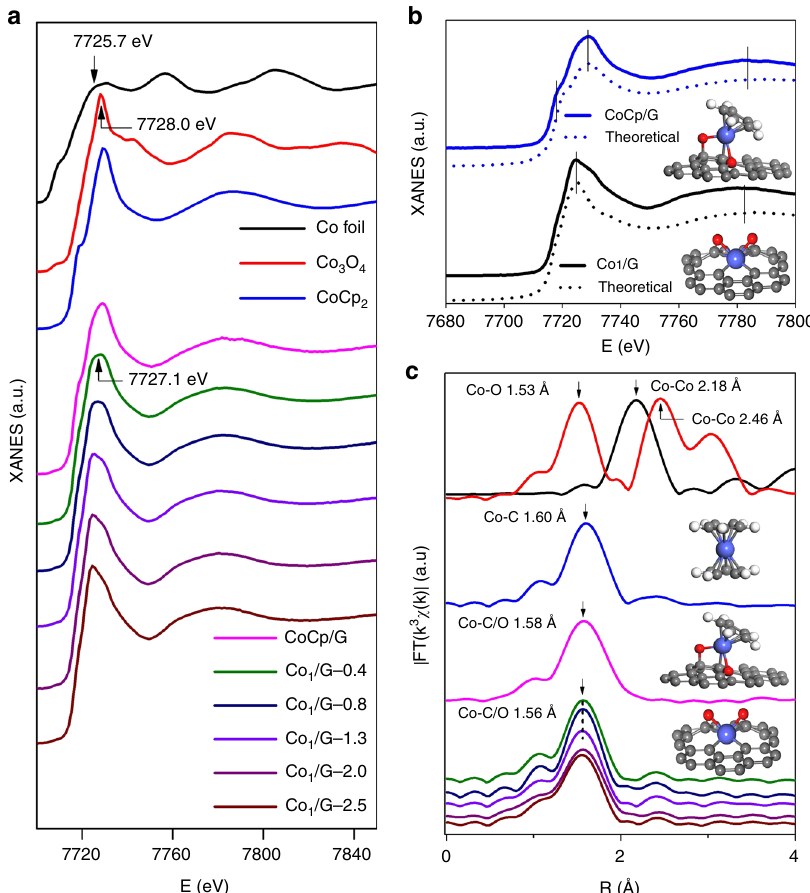
Fig. 3 Co K-edge XAFS and EXAFS spectra of CoCp/G, Co 1 /G SACs. a Co K-edge XAFS spectra. b The experimental XANES curves are compared with the calculated XANES data of optimized DFT-modeled structures of Co 1 /G and CoCp/G (inset shows the atomic structures of the models). c Fourier transform (FT) extended x-ray absorption fi ne structure (EXAFS) of these samples with the corresponding structures (insets). The balls in gray, white, red, and blue represent carbon, hydrogen, oxygen, and cobalt, respectively. The Co K-edge XAFS and EXAFS spectra of Co foil, Co 3 O 4 and CoCp 2 samples are displayed for comparison. Note: the fi gure legend in a also applies to